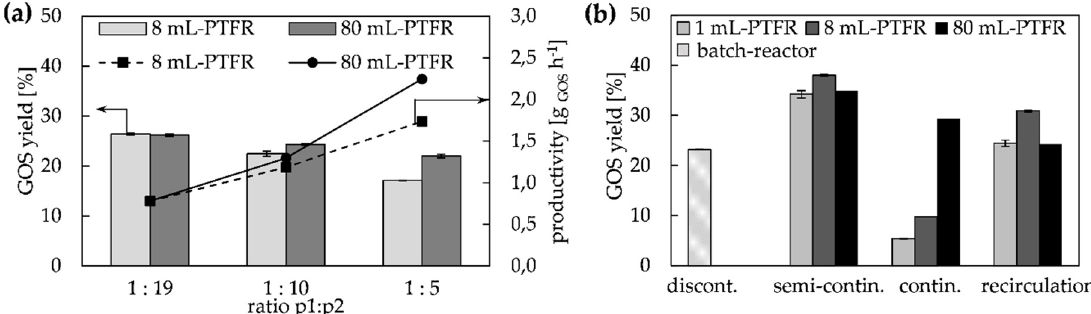
Figure 5. ( a ) GOS yield with immobilized β -gal on 8 mL- and 80 mL-PTFR with the recirculation system (Figure 2d), the rates describe the relationship between the feed flow rate (p1) and the recirculation flow rate (p2), the resulting flow rate through PTFRs was 10 mL min − 1 ; ( b ) comparison of four different configuration for GOS synthesis with free enzyme in a discontinuous batch-reactor and with immobilized enzyme in 1 mL-, 8 mL- and 80 mL-PTFRs with semi-continuous, continuous and recirculation configuration (ILC = 100 g L − 1 ).